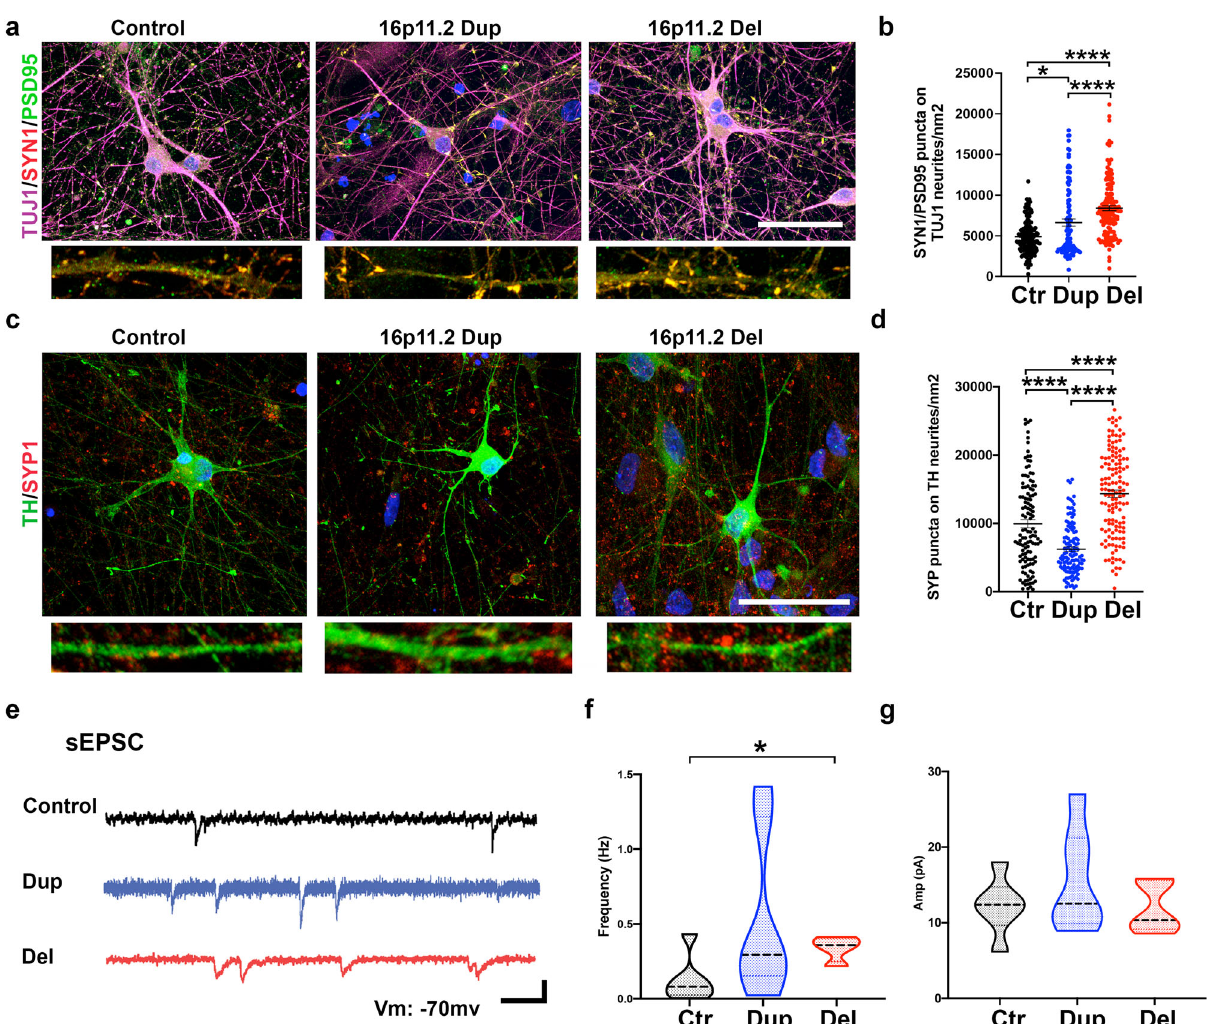
Fig. 3 16p11.2 deletion caused increased synaptic marker expression and EPSCs in the DA neurons. a Representative confocal images of the DA neurons stained with TUJ1/PSD95/SYN1. Scale bar 44 μ m. The experiment was repeated fi ve independent times with similar results. b Quanti fi cation of SYN1/ PSD95 puncta on TUJ1-positive neurites/nm 2 . 16pdel cells had higher expression of SYN1/PSD95 compared to control cells ( p < 0.0001) or compared to 16pdup cells ( p < 0.0001). Control cells had lower expression of SYN1/PSD95 compared to 16pdup cells ( p = 0.0454). Data are presented as mean ± SEM, and the number of biologically independent samples is n = 5 per each genotype. c Representative confocal images of the DA neurons stained with TH and SYP1. Scale bar 44 μ m. The experiment was repeated four independent times with similar results. d Quanti fi cation of SYP1 puncta on TH-positive neurites/ nm 2 . 16pdel cells had higher expression of SYP1 compared to control cells ( p < 0.0001) or compared to 16pdup cells ( p < 0.0001). Control cells had higher expression of SYP1 compared to 16pdup cells ( p < 0.0001). Data are presented as mean ± SEM, and the number of biologically independent samples is n